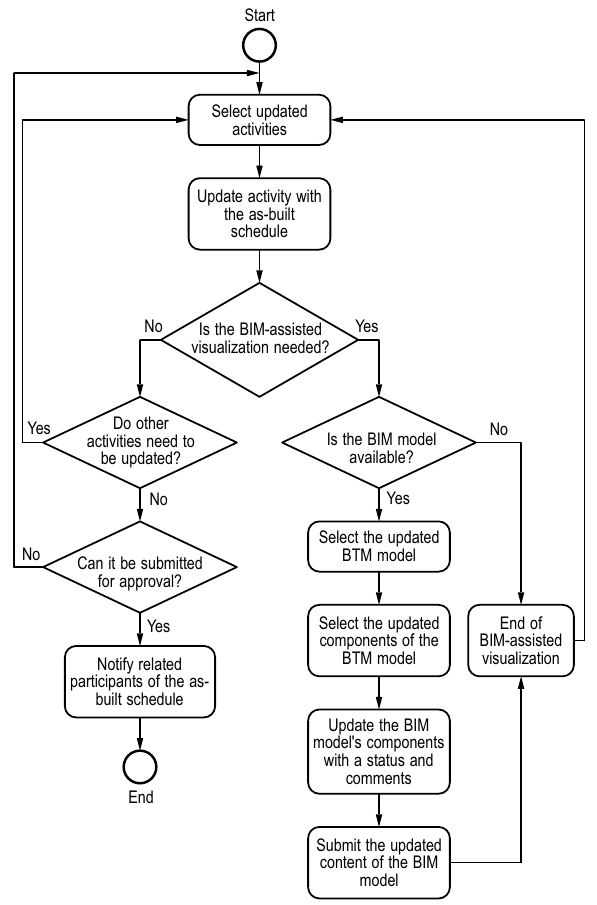
Fig. 5. The flowchart of the process used in the ConBIM-SM